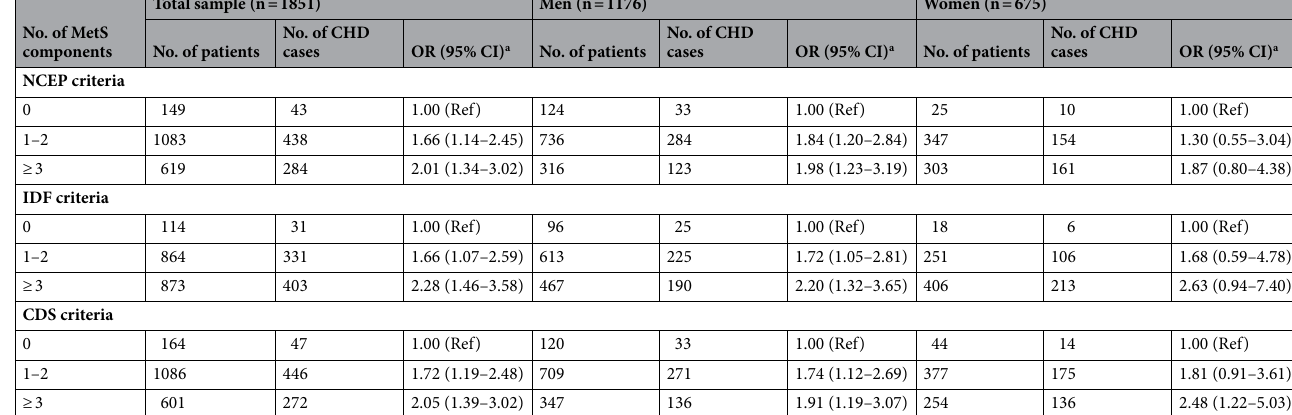
Table 4. The associations between number of metabolic syndrome components and coronary heart diseases in patients with acute ischemic stroke. MetS Metabolic syndrome, CHD coronary heart disease, OR odds ratio, CI confidence interval, NCEP National Cholesterol Education Program, IDF International Diabetes Federation, CDS Chinese Diabetes Society. a OR (95% CI) was derived from models that were controlled for age, sex, education, smoking, alcohol drinking, physical inactivity, and dietary, and if applicable, for